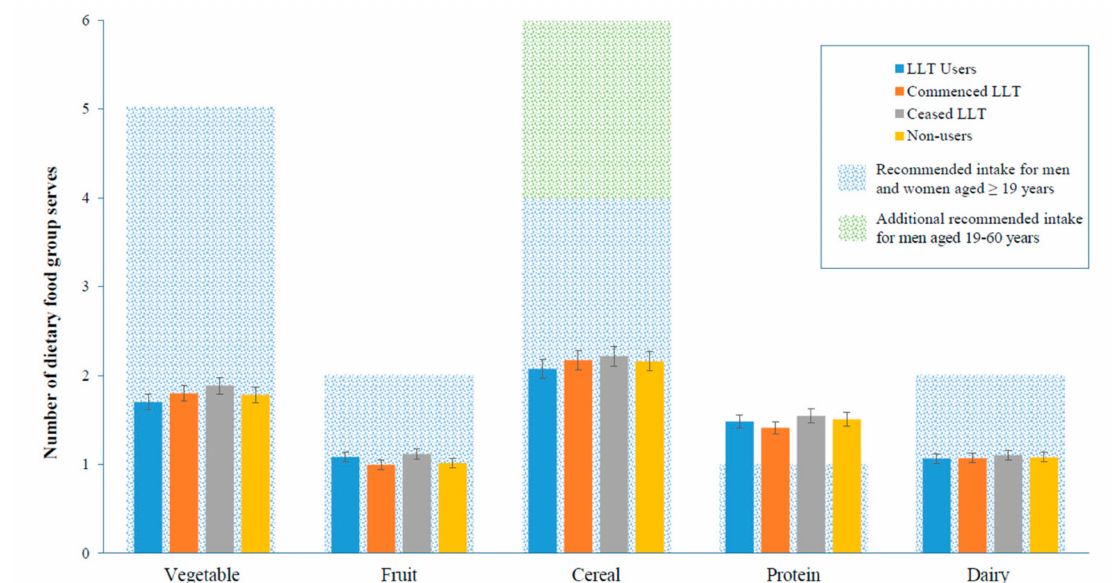
Figure 1. Adjusted total serves per day at the follow up of key food groups at the 25th quantile, by LLT (Lipid-lowering therapy) status, median (95% CI). Adjusted for age, gender, body mass index (kg / m 2 ), smoking status, exercise status, education status, diabetes status, prior cardiovascular disease, hypertension, and baseline dietary serves per day.